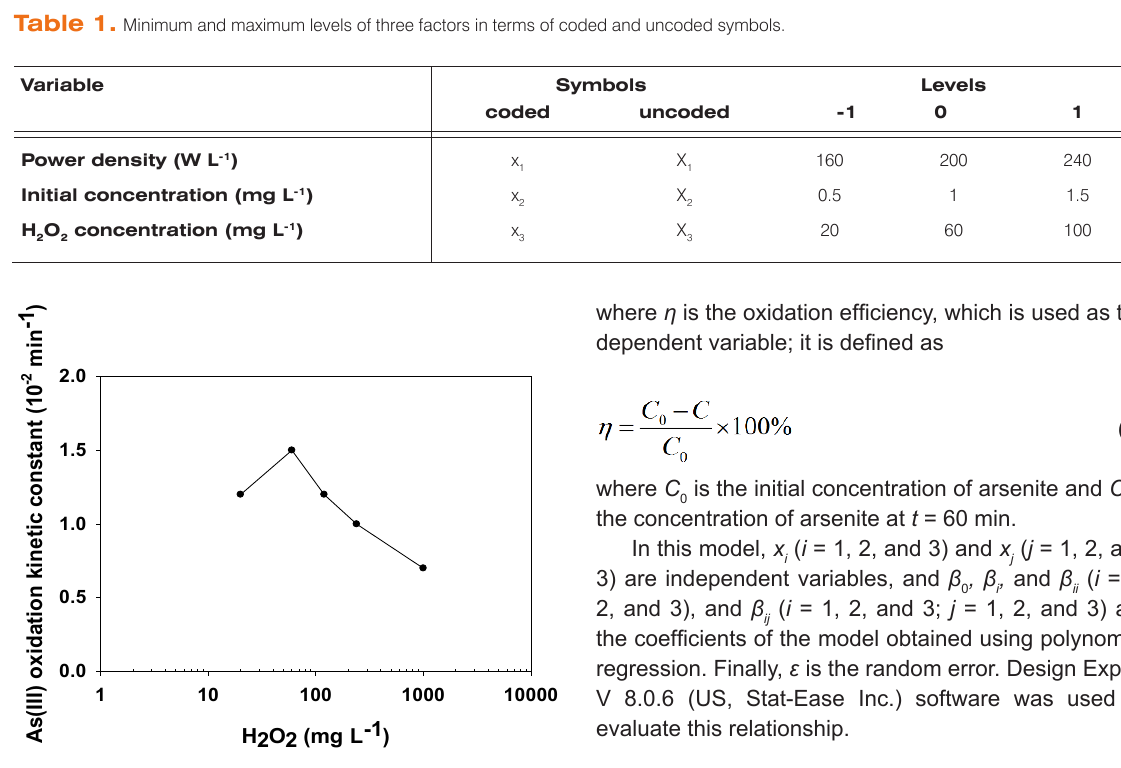
O concentration 2 2